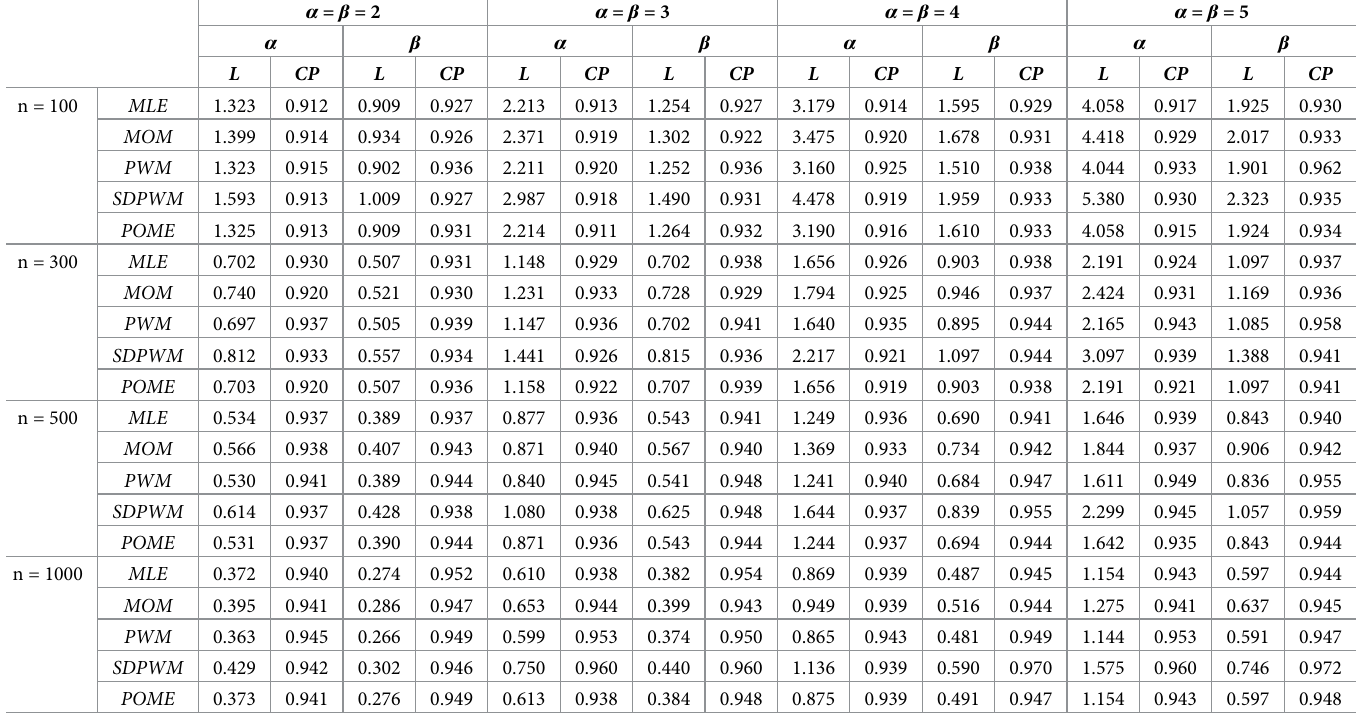
Table 8. The average length (L) and coverage probability (CP) of the bootstrap confidence intervals for α and β when α = β and for different choices of n